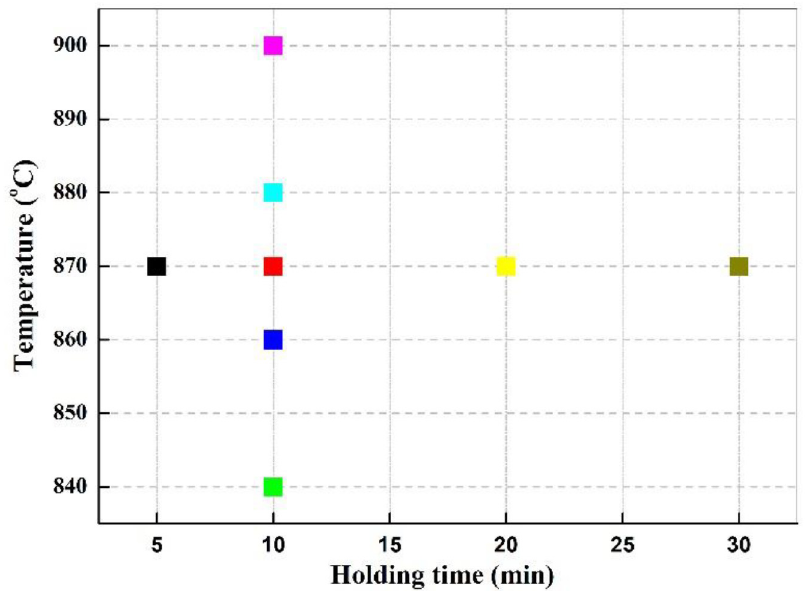
Figure 2. Brazing process parameters of Ti 3 SiC 2 ceramic/copper joints.